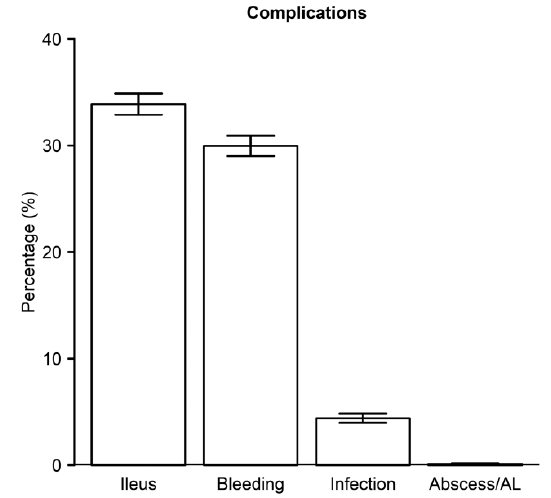
Figure 1. Common post-admission colectomy complications.